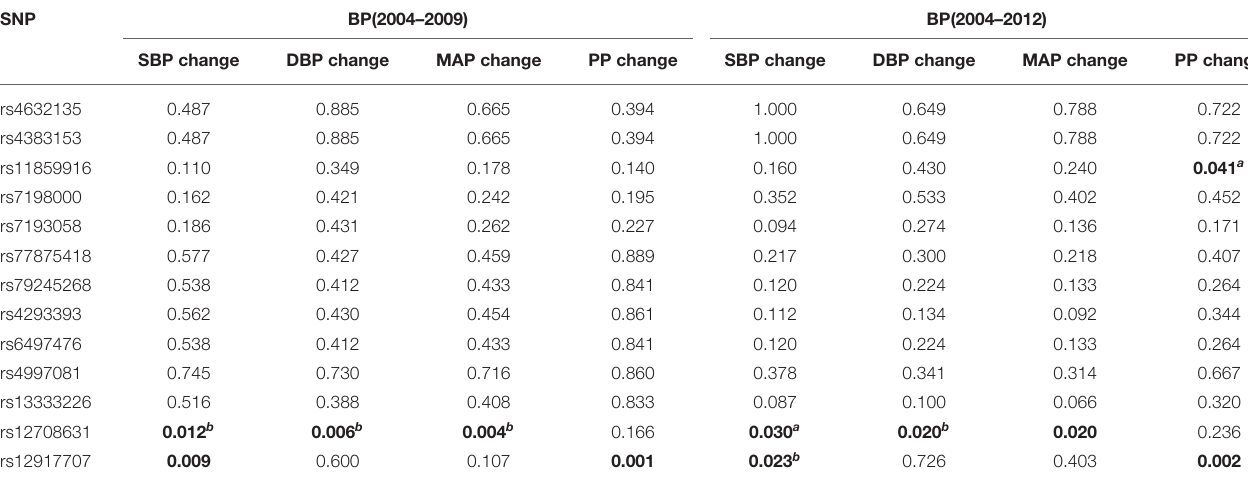
TABLE 2 | Association of UMOD SNPs with longitudinal blood pressure changes changes blood pressure from baseline to the follow-ups. SNP